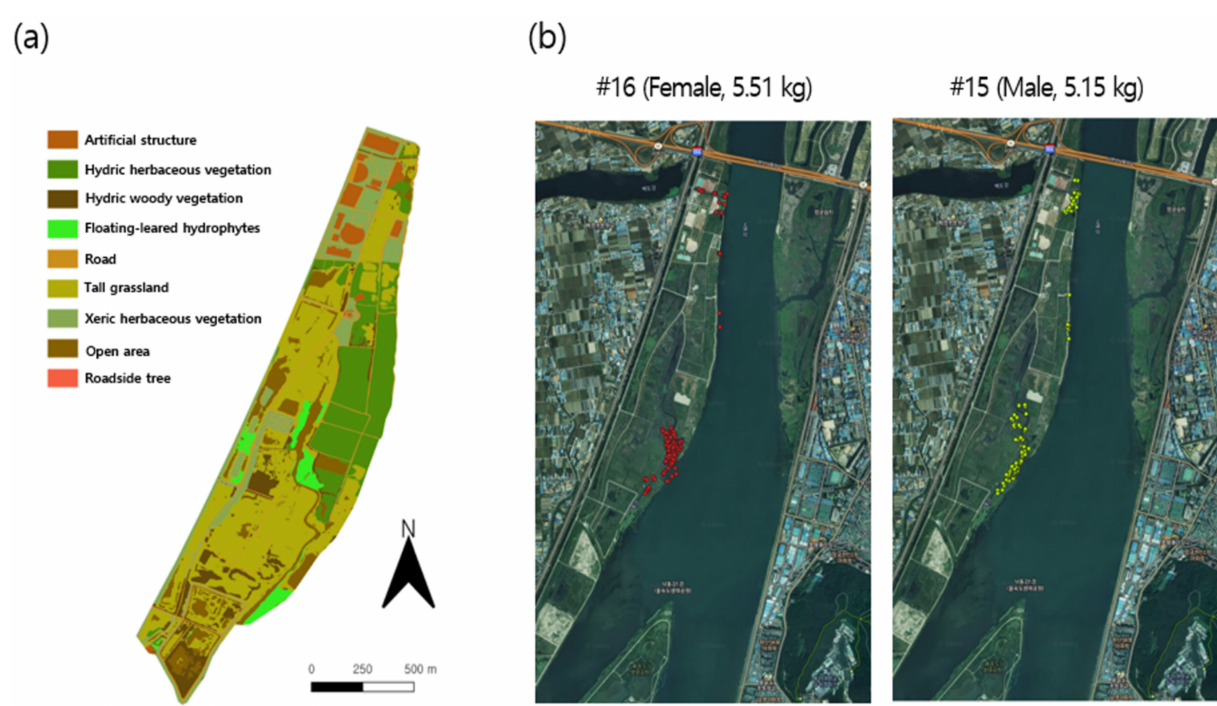
Figure 2. ( a ) Spatial habitat types in the Macdo wetland during the survey period and ( b ) examples of individual movement tracks in the survey